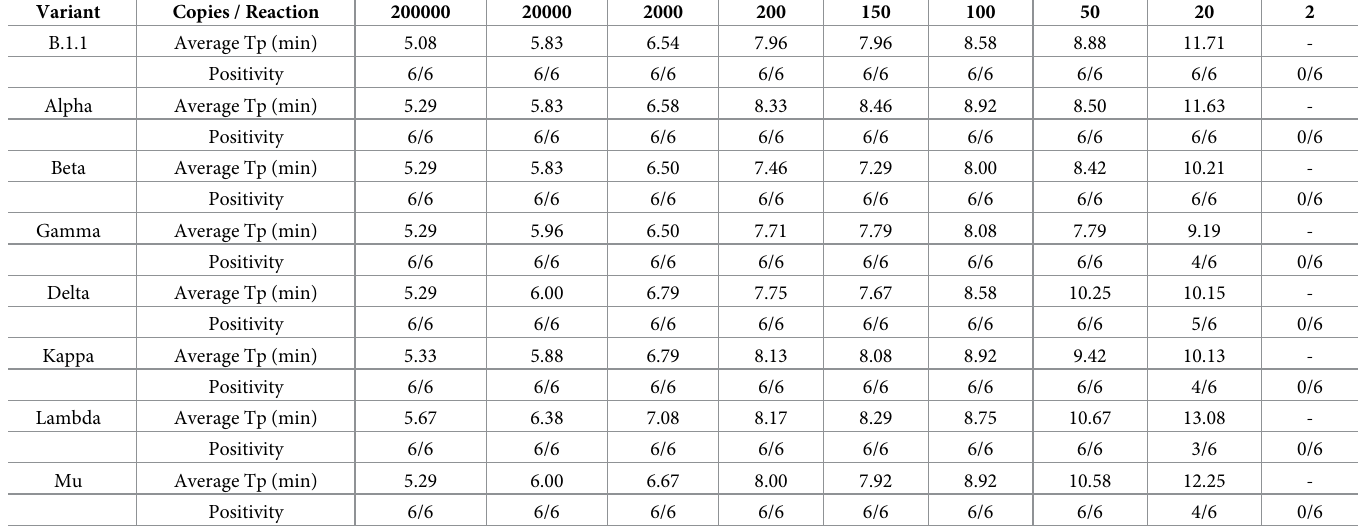
Table 2. Evaluation of the sensitivity of RT-LAMP assay using viral RNA of SARS-CoV-2 variants. Variant